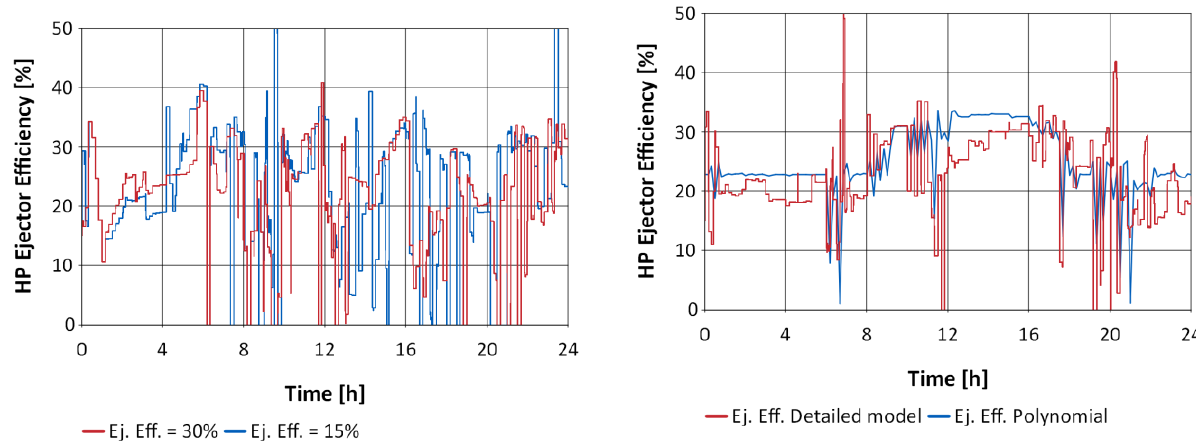
Figure 6. Calculated ejector efficiency for a standard operation period for the high-pressure ejectors with the detailed model, using boundary conditions from system simulations with constant ejector efficiency of originally 30% and 15% ( left ), and ejector efficiency based on polynomials after mapping the detailed model (right).